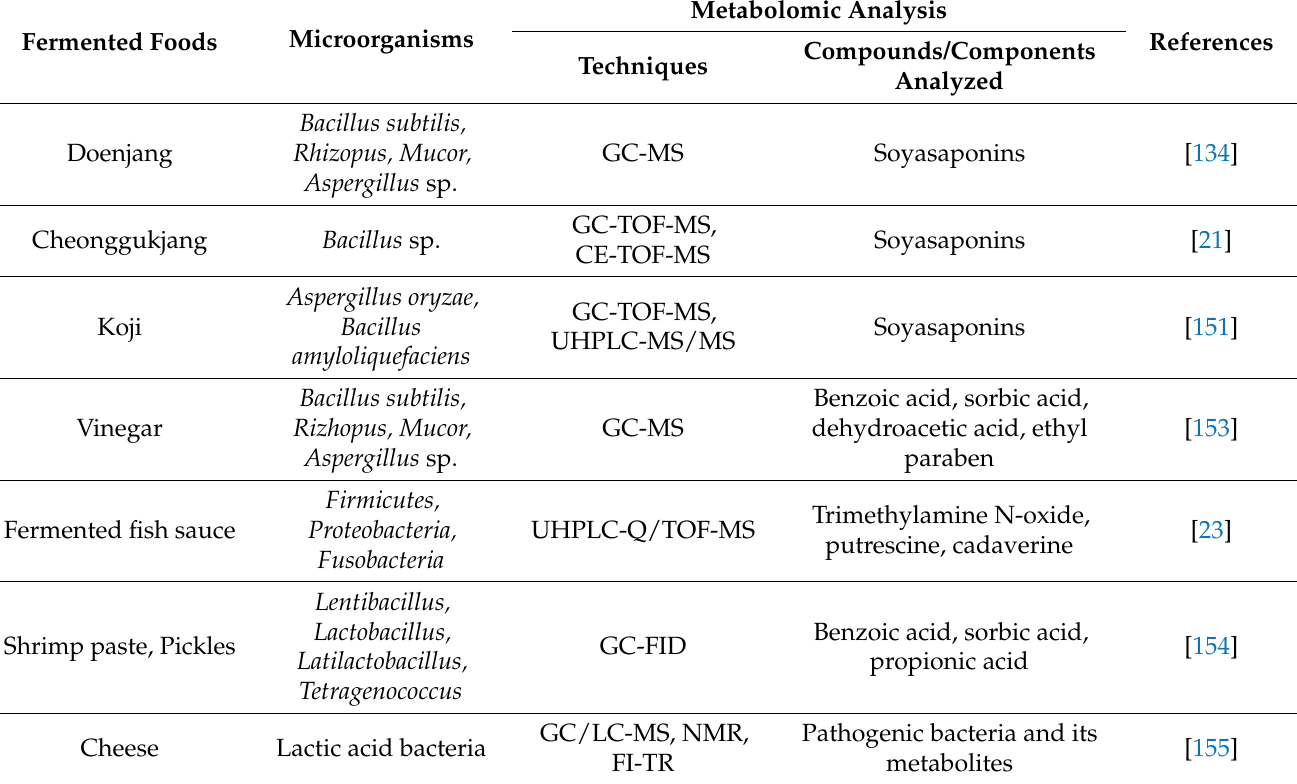
Table 4. Metabolomic analyses applied to different fermented foods considering safety properties.